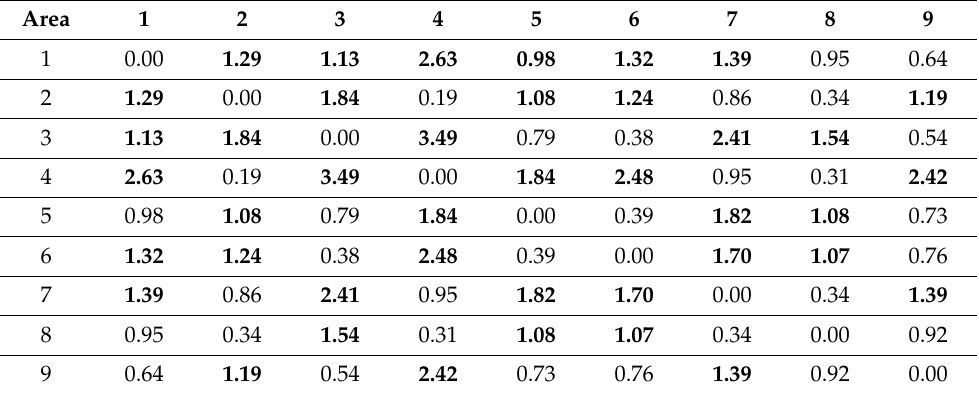
Table 2. Ratio between actual K t (in formula 3) and critical K t , 5% (5% significance) variance, Student t